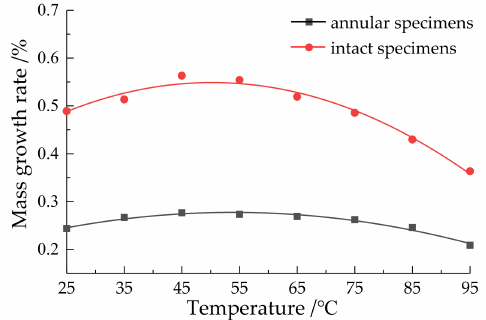
Figure 5. Mass growth rate varies with water